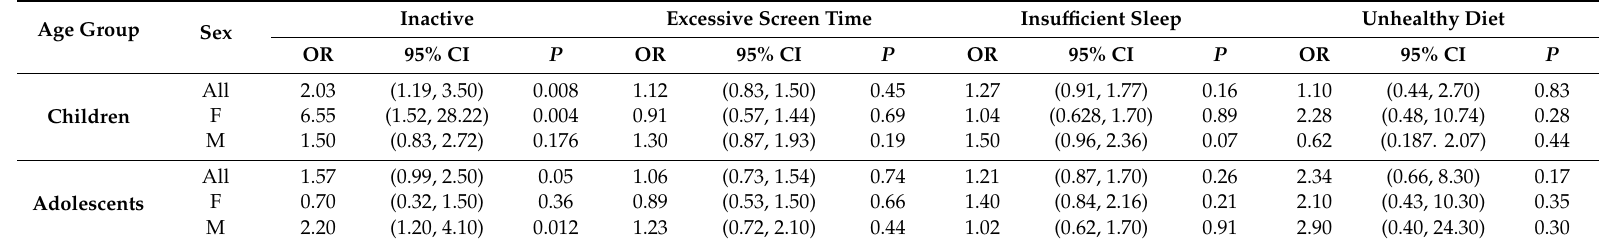
Table 4. Risk association for overweight / obesity (OW / OB) according to the presence or absence of each OL component in Mexican children and adolescents. Age